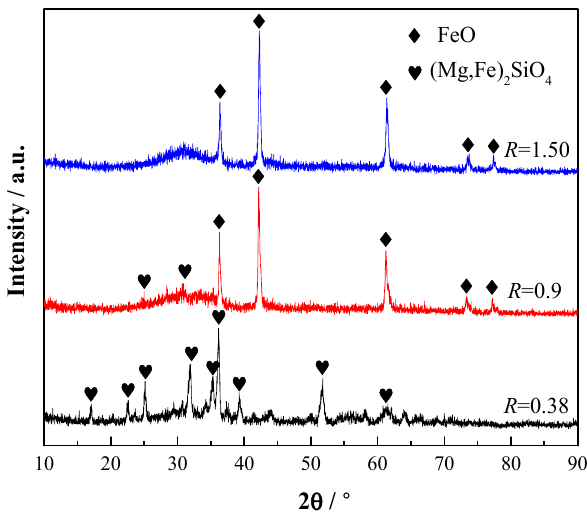
Figure 10. XRD spectrum of the CaO-SiO 2 -FeO-MgO system.